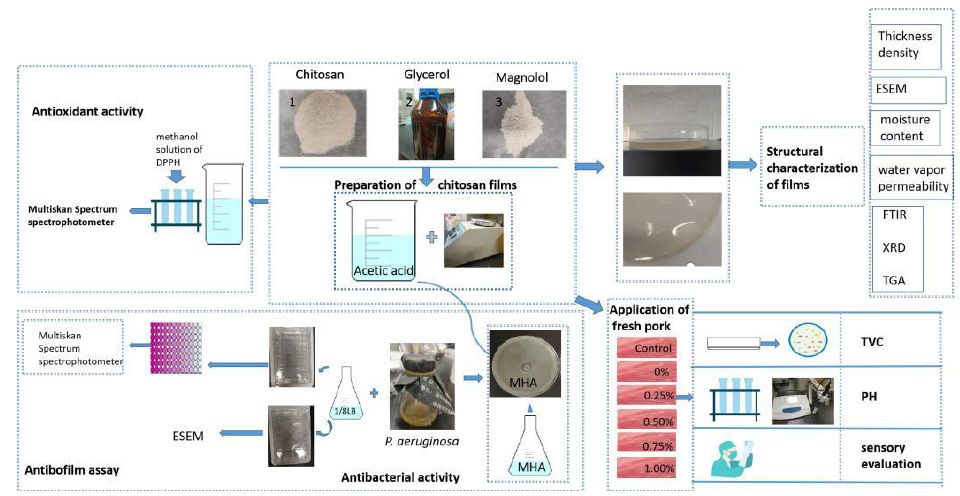
Figure 8. Method summary diagram.